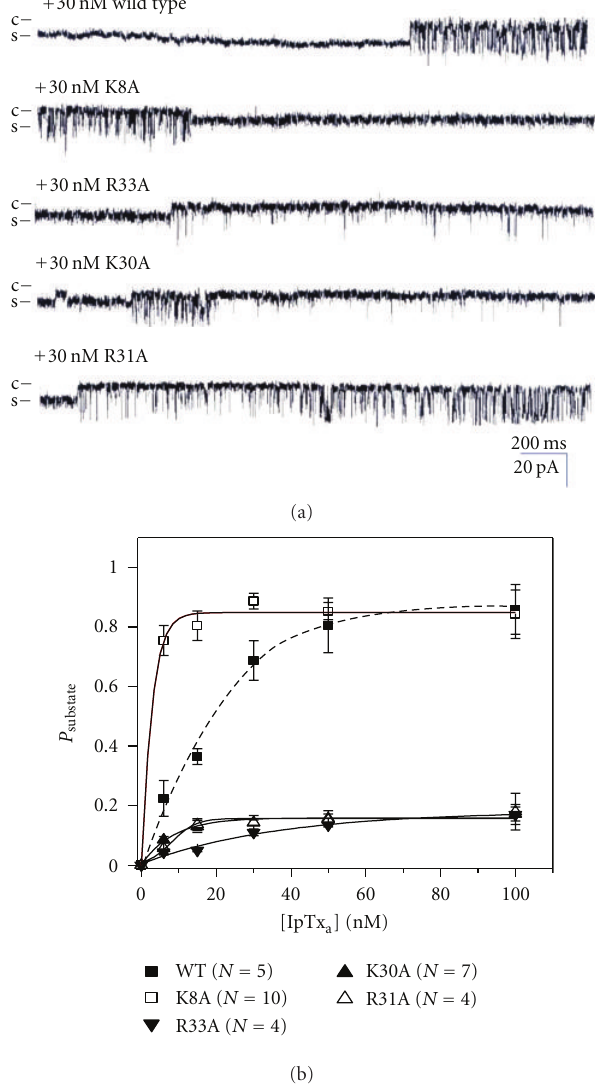
Figure 5: Properties of single channel gating in wild-type and mutant IpTx a -modified purified RyR1. (a) Single channel currents of purified RyR1 activated in the presence of wild-type or mutant IpTx a were measured at − 30 mV holding potential. The single channel opening is shown as a downward deflection. The recordings of single channel currents were measured at 30 nM wild-type or mutant IpTx a in the cis solution. (b) The plots of P substate of purified RyR1 versus wild-type or mutant IpTx a at various